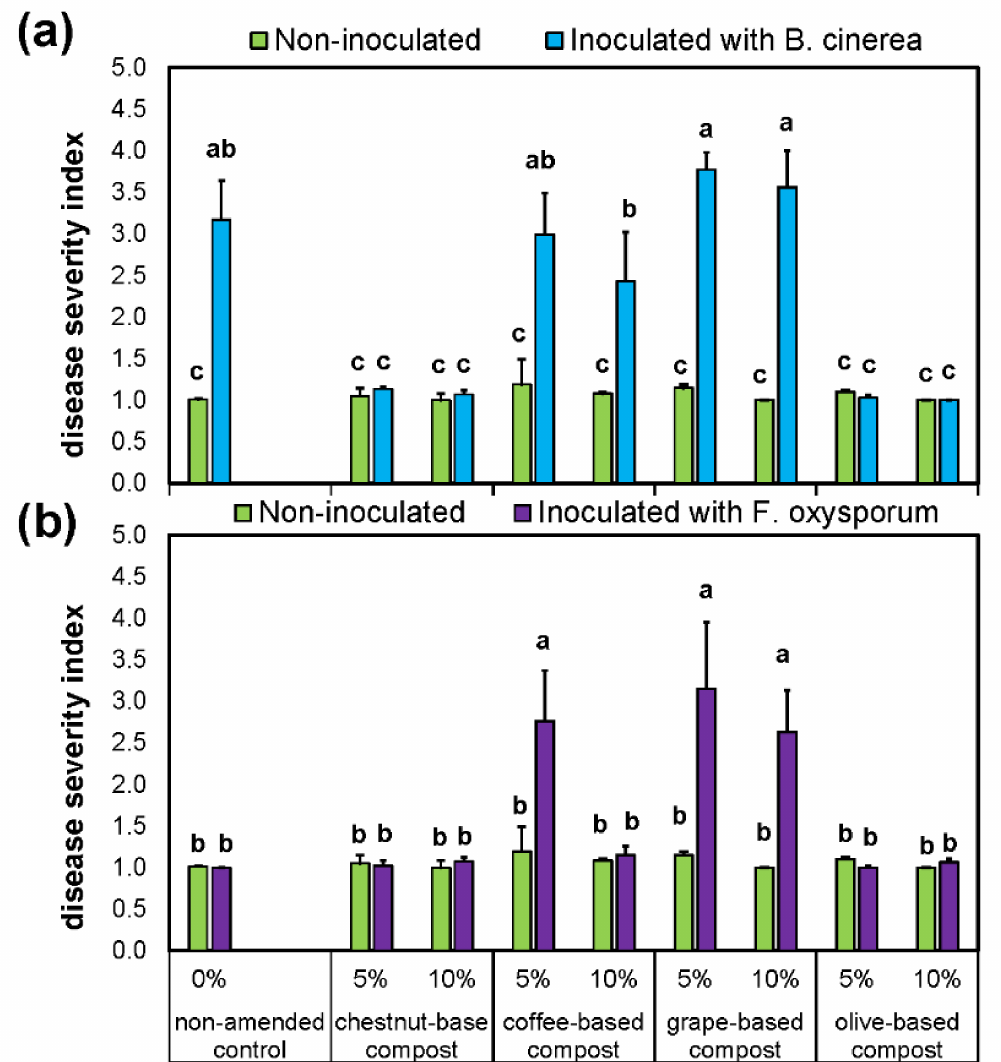
Figure 2. Disease severity of ( a ) gray mold and ( b ) Fusarium wilt in lettuce plants grown on soil/compost mixes inoculated with B. cinerea and F. oxysporum . The composts were incorporated into soils at proportions of 5% and 10% (weight basis). Control treatments consisted of non-amended soils. A semi-quantitative scale from 1 to 4 was used to rate the severity of the disease, where: 1 = no symptoms; 2 = leaf yellowing; 3 = stem wilting; and 4 = plant dead. Different letters above the bars indicate significant differences among means ( p < 0.05; ANOVA/Tukey’s